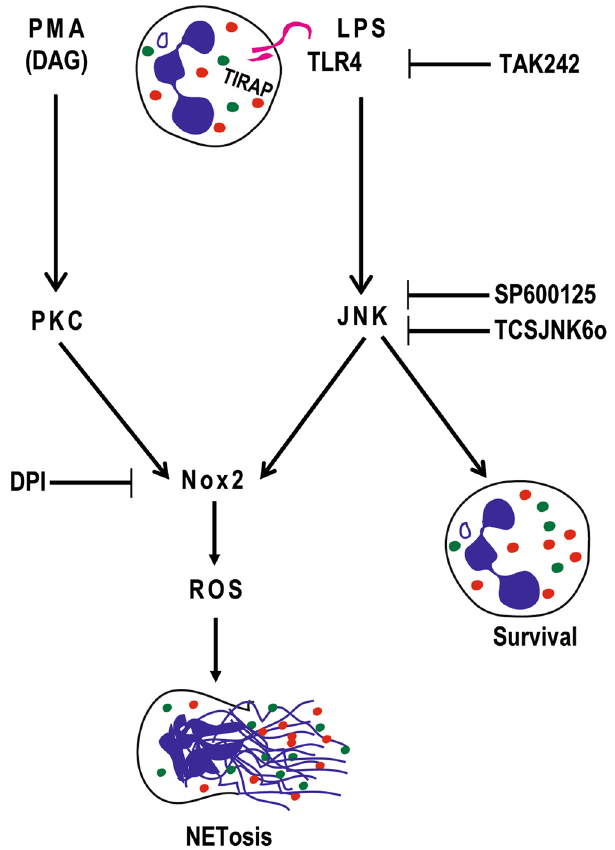
Figure 9. LPS-TLR4-JNK axis regulates Nox-dependent suicidal NETosis. PMA and LPS regulate ROS production in neutrophils via PKC and JNK, respectively. Blocking TLR4 signaling with TAK242 and JNK activation with SP600125 or TCSJNK6o during LPS-mediated NETosis results in the suppression of ROS production and Nox-dependent NETosis, and increased survival of neutrophils. Nox inhibitor DPI suppresses both PMA- and LPS-mediated NETosis. Color dots represent different granular proteins. Granule decorated strings represent DNA and NETs. Specific inhibitors and their points of inhibitions are indicated. Based on all the data obtained in this study, we propose that LPS-TLR4-JNK signaling cascade acts as a sensor of LPS concentrations and bacterial load, and turns on the neutrophil death mode to the suicidal Nox-dependent